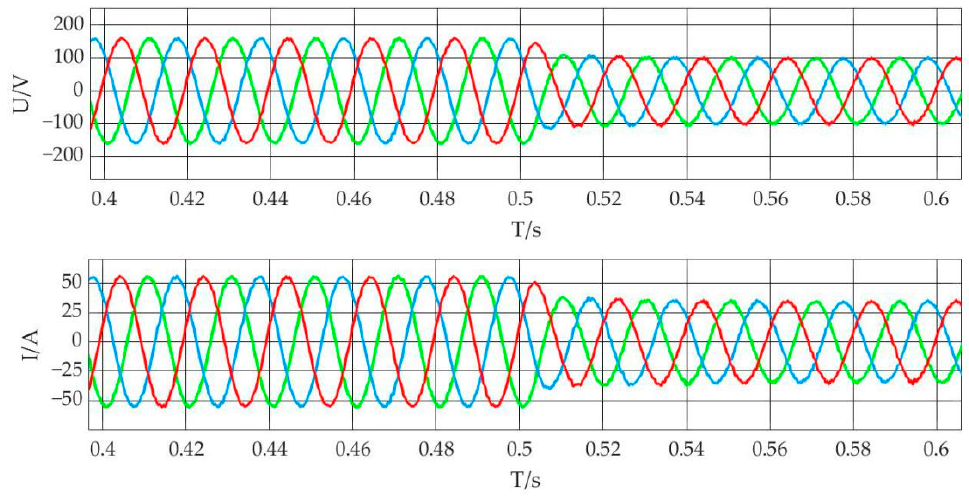
Figure 13. Voltage and current diagram of the second type isolated island of electric spring.